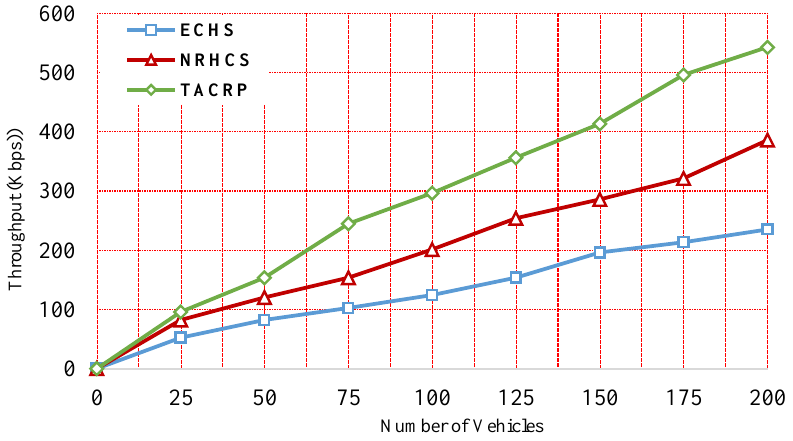
Figure 5. Network Throughput Calculation.